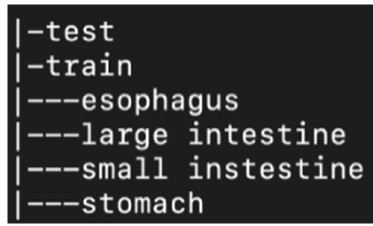
Figure 1. Folder structure.